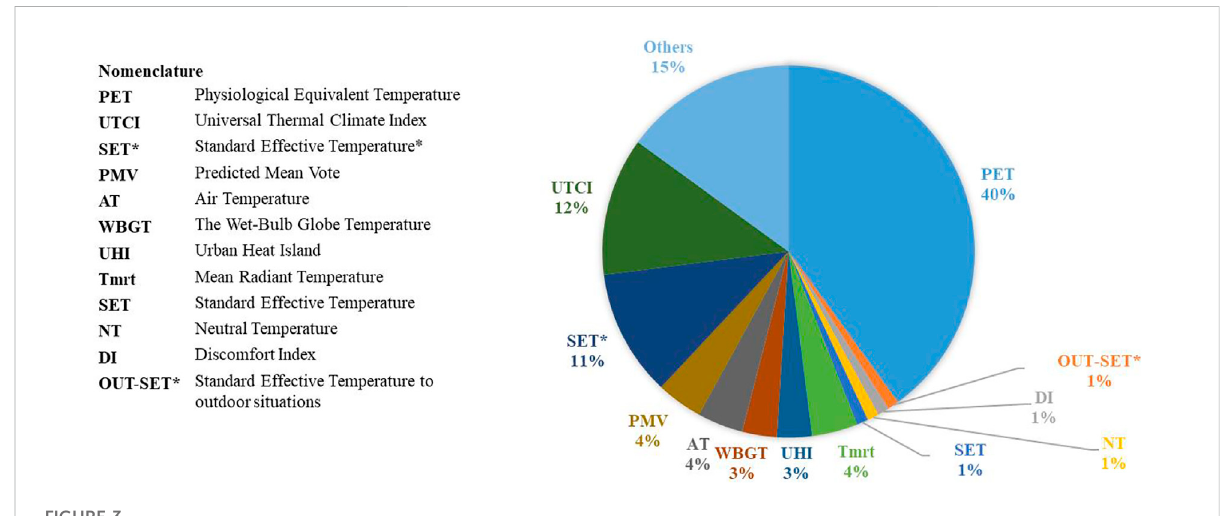
FIGURE 3 Frequency of thermal comfort indices application in outdoor thermal comfort studies of China. *Data from (Li and Liu, 2020)